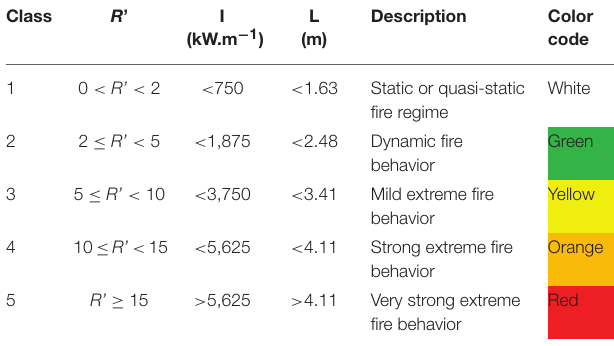
TABLE 1 | Classes of fire behavior